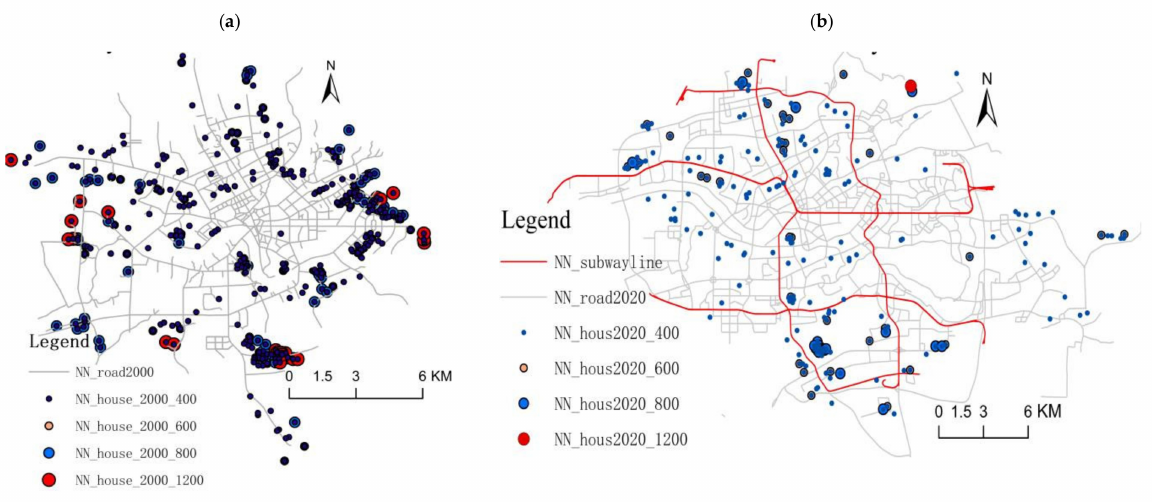
Figure 7. Distribution of RCs outside a given distance threshold of Nanning in 2000 ( a ) and 2020 ( b